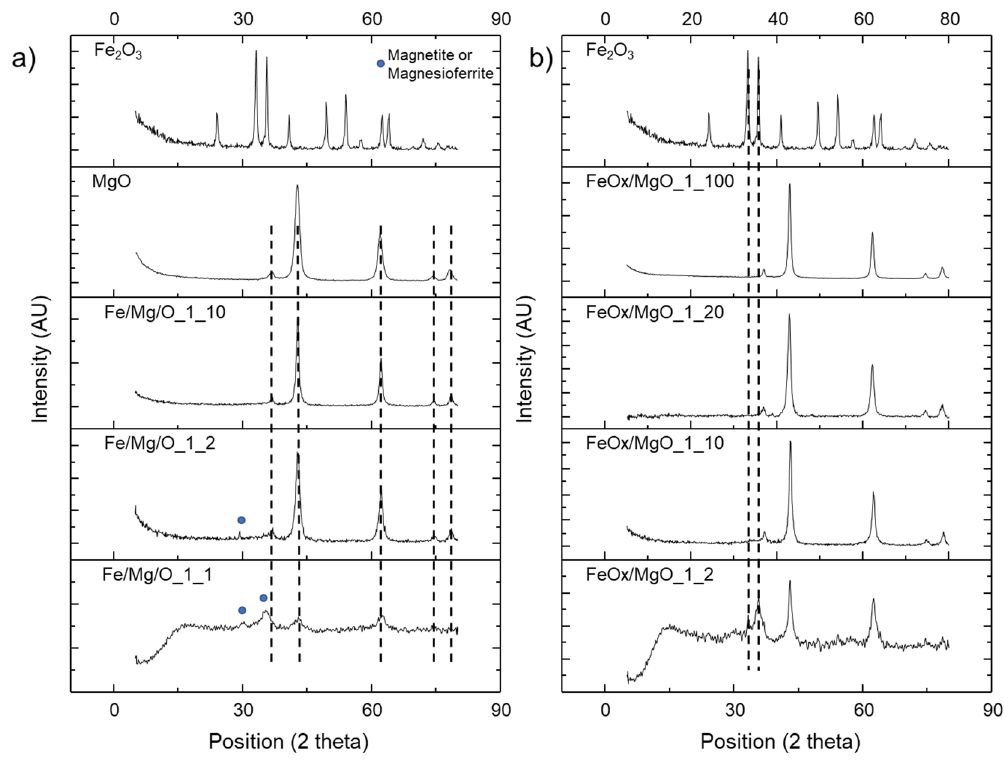
Figure 1. XRD patterns of ( a ) coprecipitated samples and ( b ) impregnated samples.